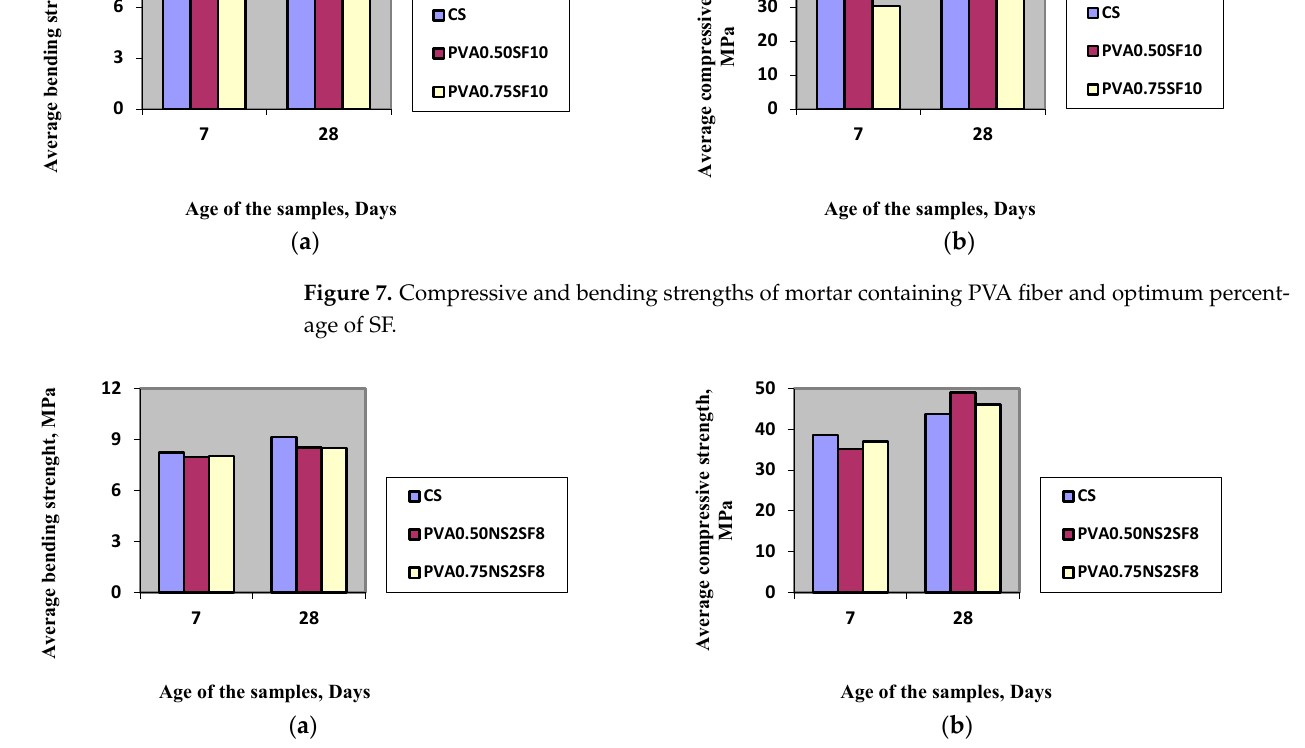
Figure 8. Compressive and bending strengths of mortar containing PVA fiber and optimum percentages of NS and SF.